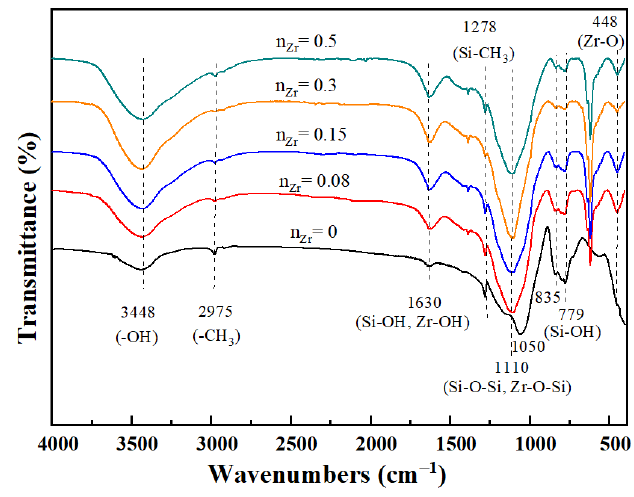
Figure 3. FTIR spectra curves of ZrO 2 -MSiO 2 materials with various n Zr .